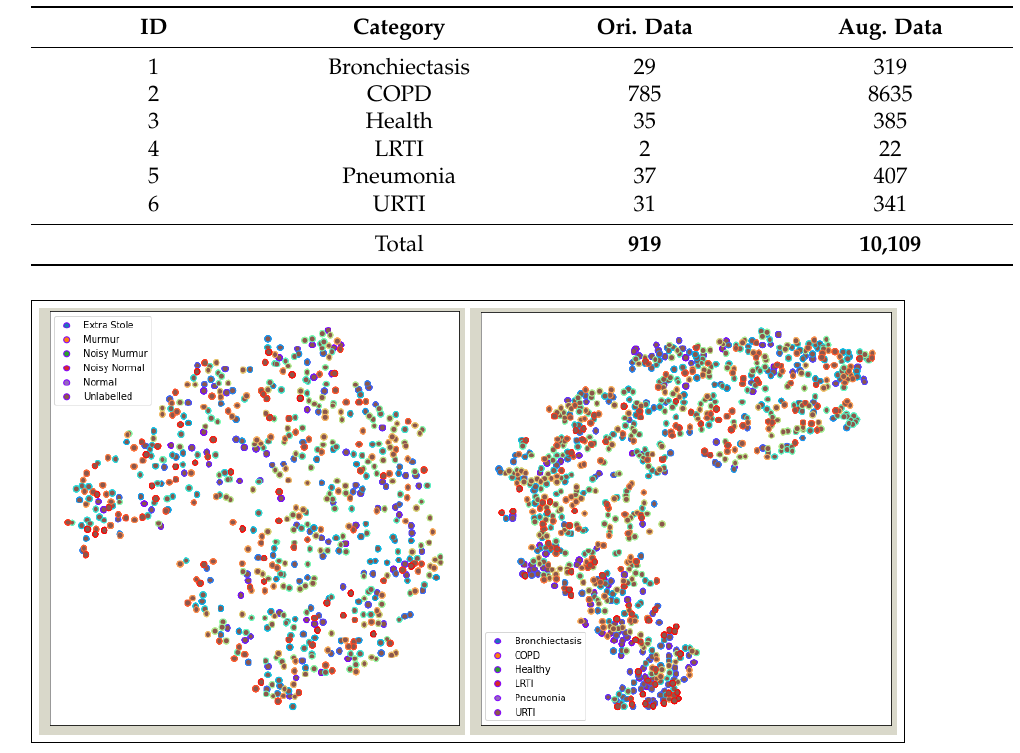
Table 7. Lung Sound Dataset: Original and Augmented Data.